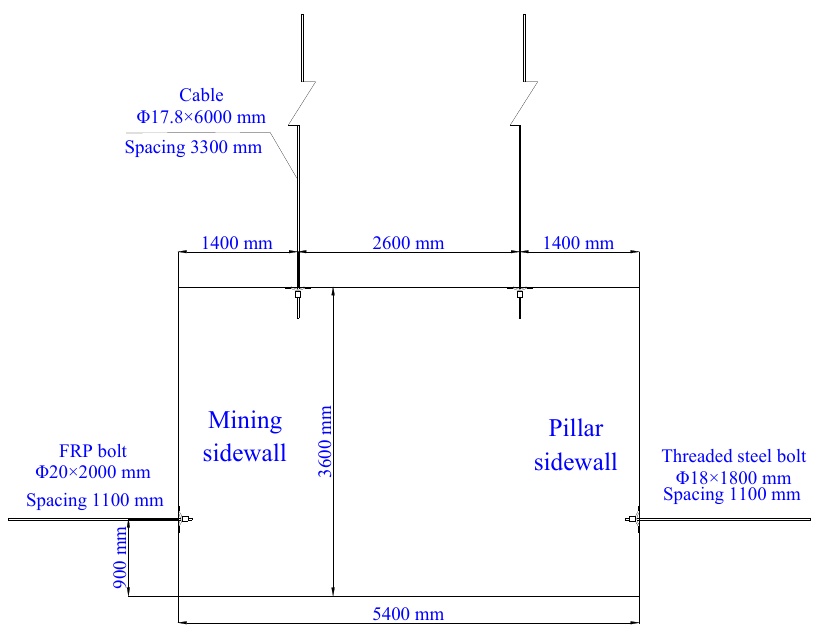
Figure 15. Reinforcement scheme of the strong mining roadway (net section).